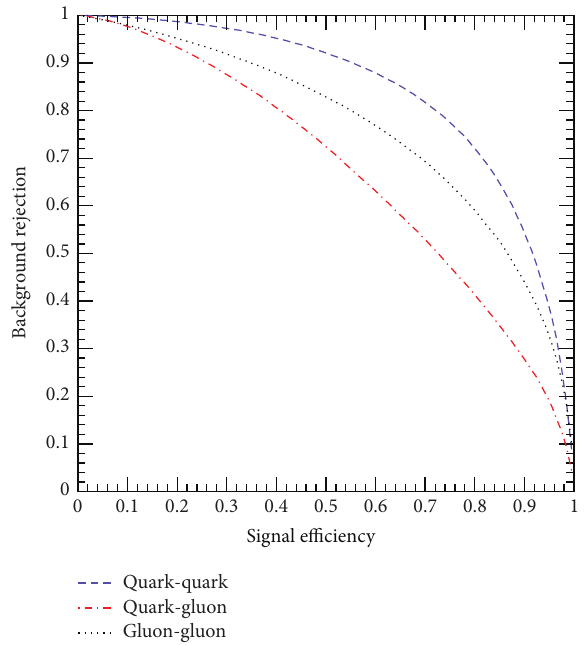
Figure 3: ROC curves of each type of parton pairs. The greatest background rejection is achieved for quark-quark parton pair tagging.